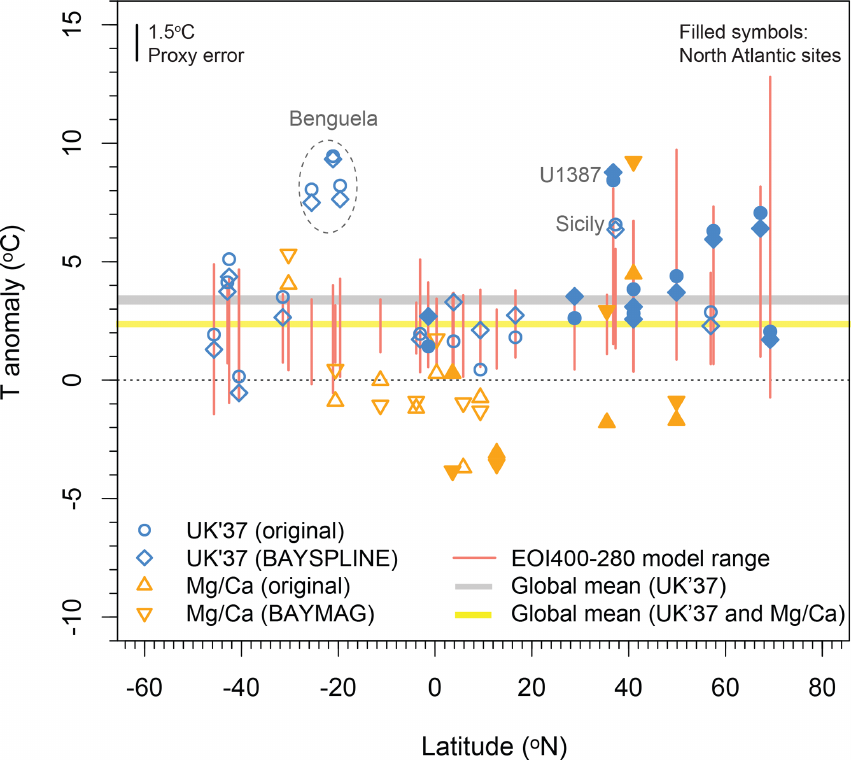
Figure 4. Reconstructed and modelled SST anomalies plotted by latitude. SST reconstructions using the original published data and two Bayesian approaches (BAYSPLINE, BAYMAG) are shown. The anomalies are calculated with reference to the NOAA-ERSST5 data for the years 1870–1899CE at each site. Vertical red lines show the range of modelled annual SSTs from all PlioMIP2 experiments (Haywood et al., 2020) calculated at the grid boxes containing each